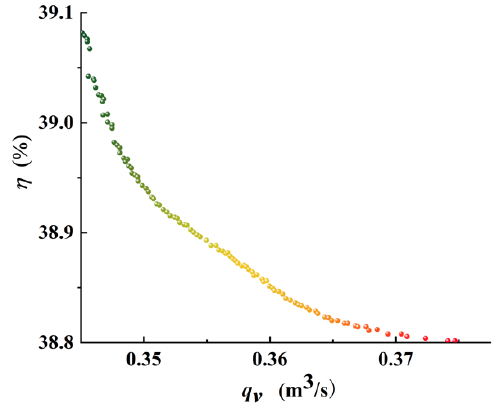
Figure 12. Optimization objective Pareto frontier.